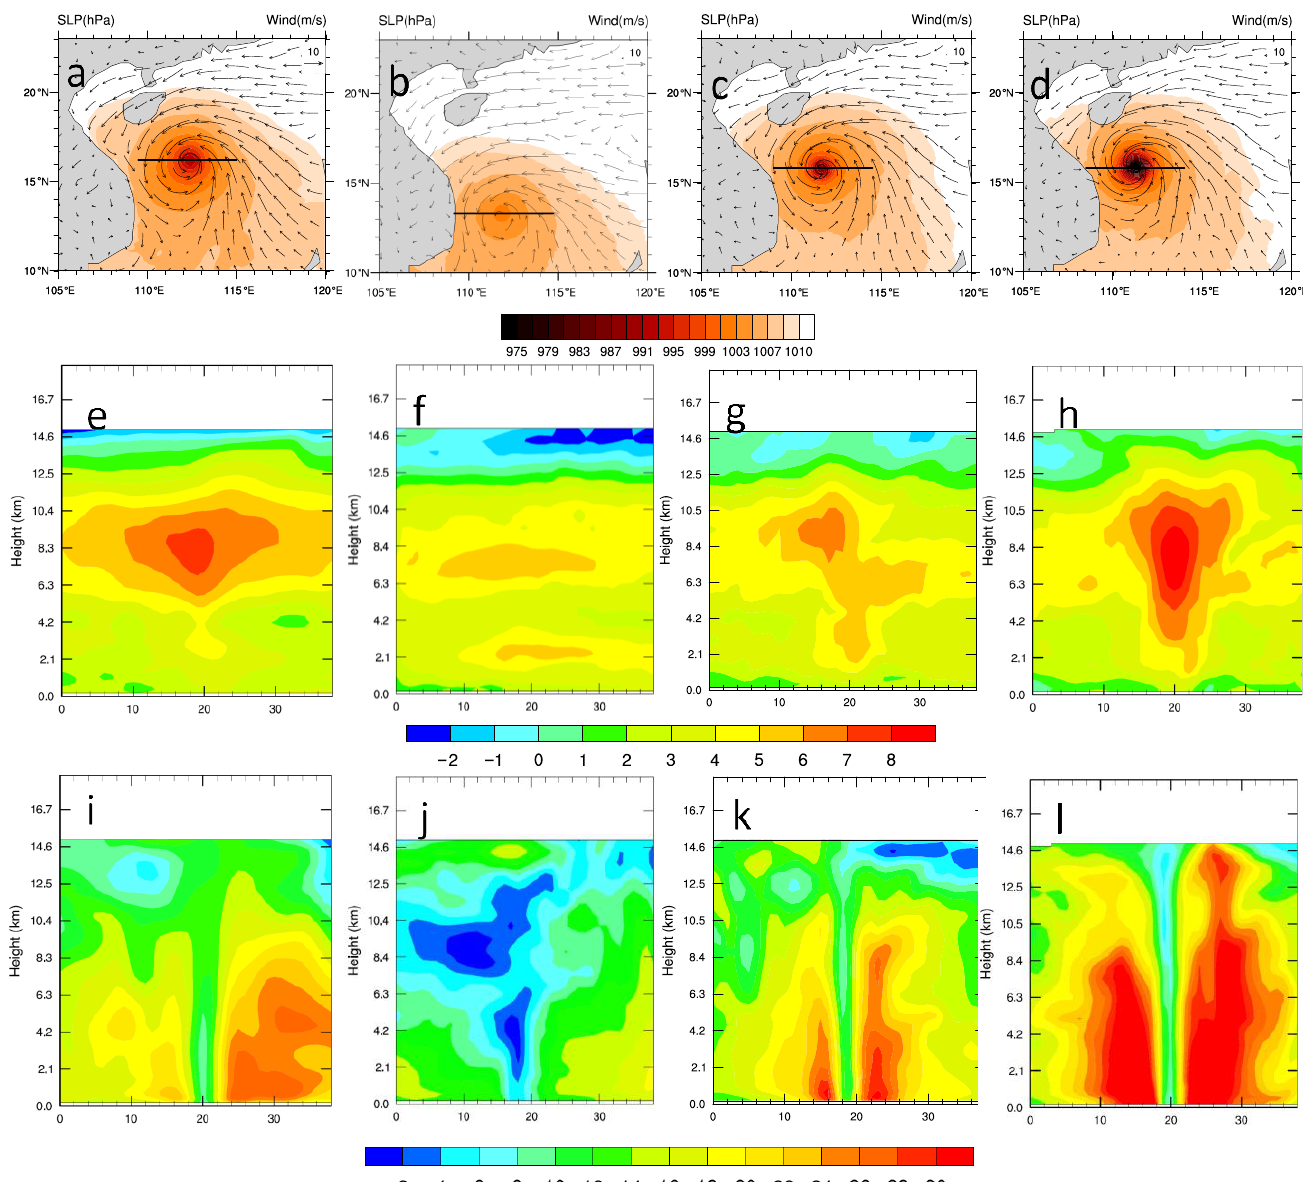
Figure 7. ( a – d ) The surface wind vectors and sea level pressure (color-shaded) from the analyses of the ECMWF, CTRL, CON, and AMWRI, respectively; ( e – h ) the west–east cross-sections of temperature anomalies for the ECMWF, CTRL, CON, and AMWRI, respectively; and ( i – l ) the horizontal wind speed through the vortex center for the ECMWF, CTRL, CON, and AMWRI, respectively, at 1800 UTC on 26 October. The x -axis of ( e – l ) is the grid number along the black line in ( a ).